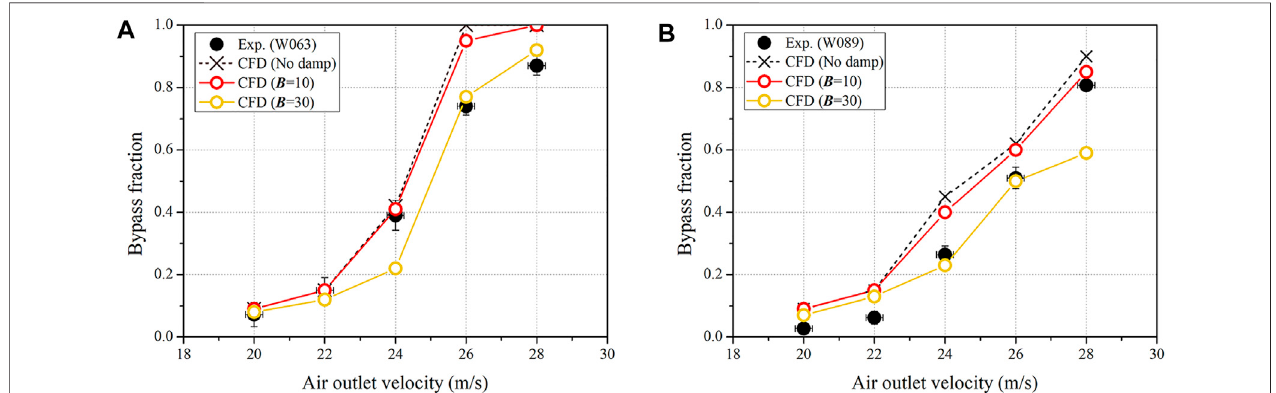
FIGURE 13 | (A) vf = 0.63 m/s, (B) vf = 0.89 m/s. Change in bypass fraction with B